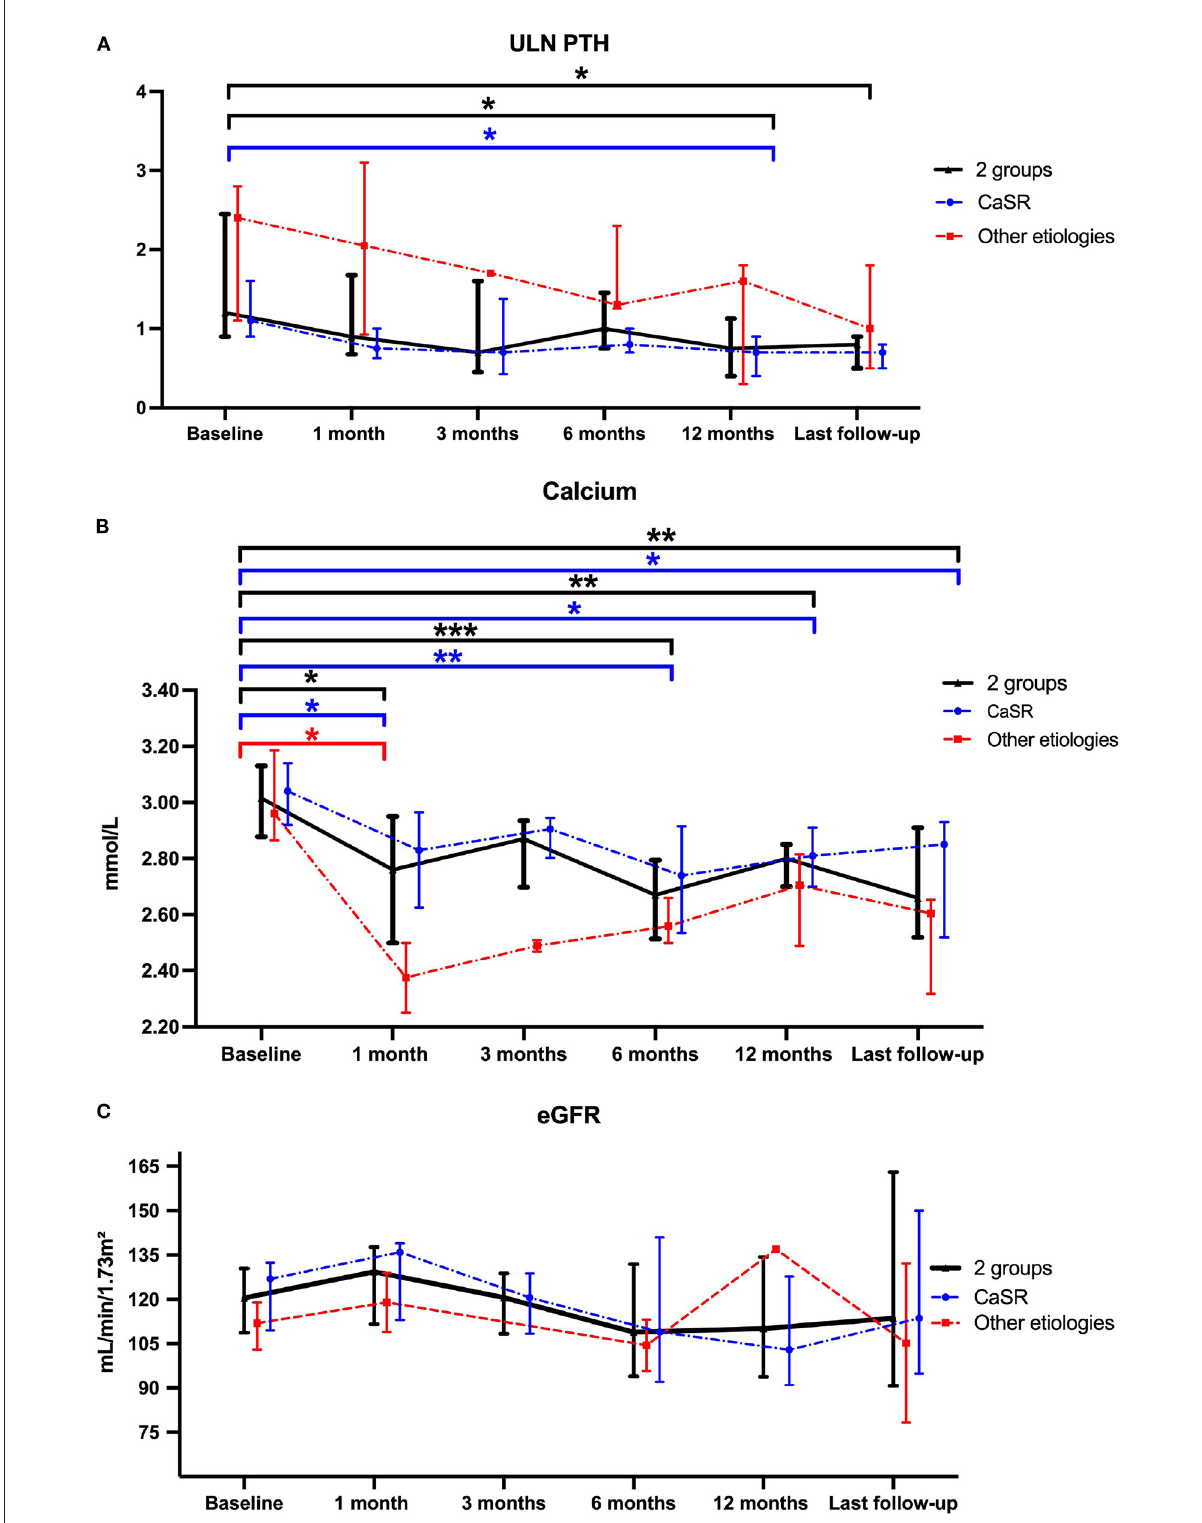
FIGURE1 Comparison of ULN-PTH (A) , total calcium (B) and eGFR (C) data at Cinacalcet cinacalcet initiation and during follow-up. Each dot on the graph represents median with interquartile range of different biological data levels at the different time-points. Statistical analyses were performed with Kruskall–Wallis test: * p < 0.05, ** p < 0.01 and *** p < 0.001. The blue line represents the “ CASR mutation patients” sub-group, the red line represents the sub-group of patients without CASR mutation and the black line represents these 2